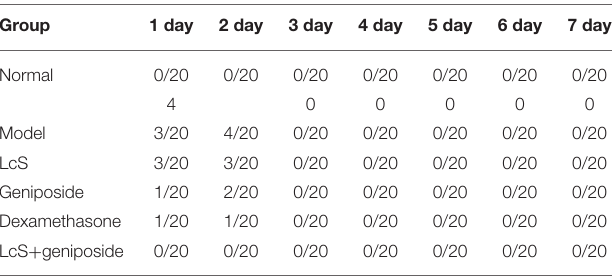
TABLE 2 | Death rate of mice with sepsis (number of dead mice/total number of